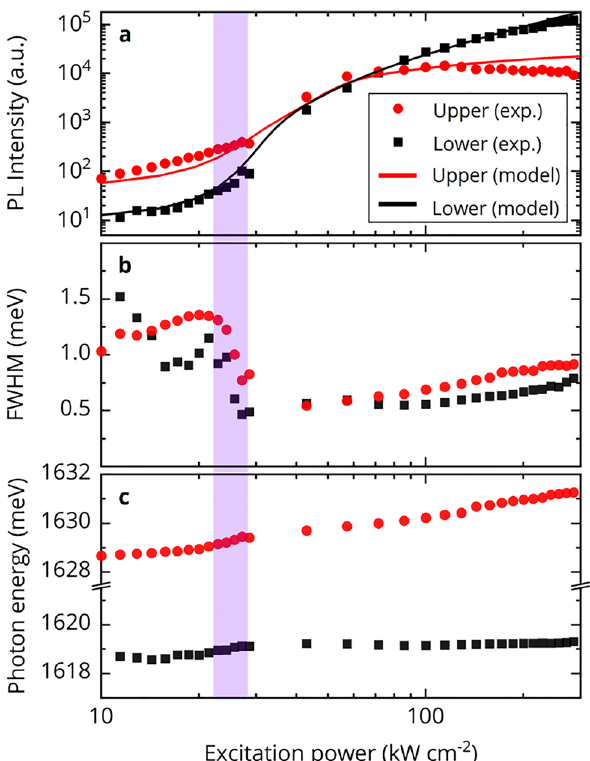
Figure 4: Emission properties of the two lowest polariton branches at k ∥ = 0 as a function of the excitation density (points). Polariton condensation and lasing occur for both levels at approximately the same threshold, as revealed by (a) a non-linear increase in intensity, (b) narrowing and (c) energy blueshift of the emission. Solid lines represent the result of the model calculation (see the text for details). Excitation power density increases for 1.43 kW cm − 2 (45 μ W per spot of the diameter of 2 μ m) in the range below 28.6 kW, and for 14.3 kW cm − 2 (450 μ W per the same spot) in the range above 28.6 kW cm − 2